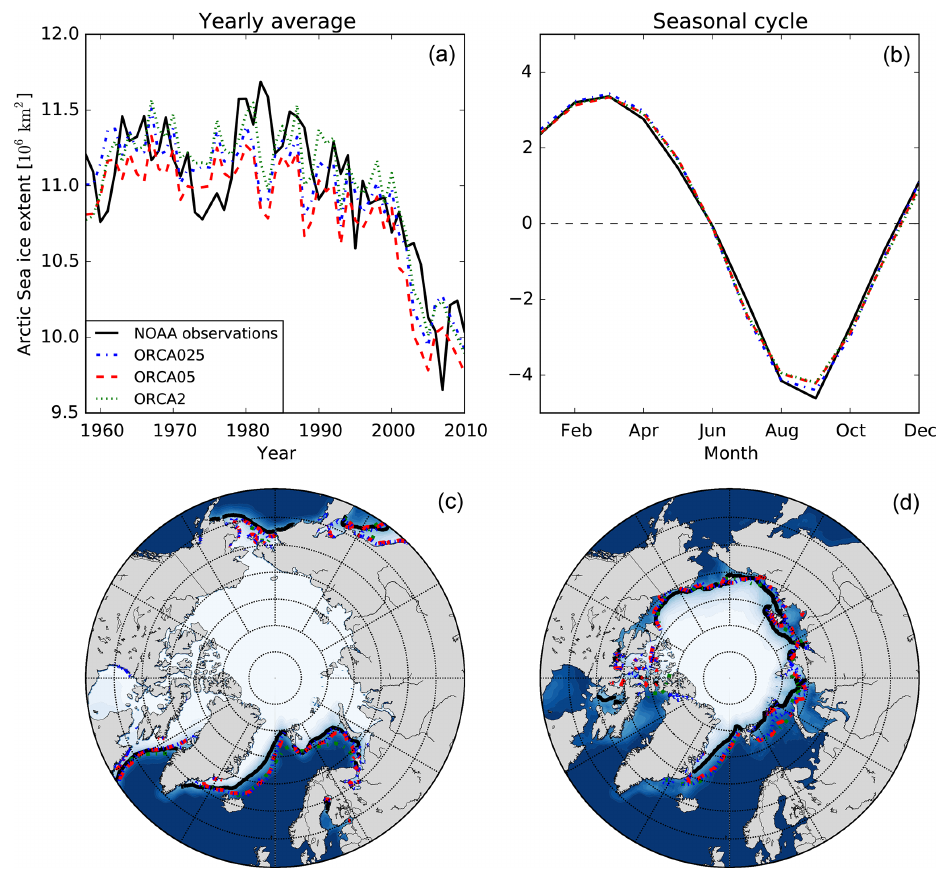
Figure 3. Sea-ice extent (a, b) and sea-ice concentration (c, d) over the Arctic from 1960 to 2012 comparing microwave-based observations from the National Oceanic and Atmospheric Administration (NOAA) (black) to simulated results from ORCA2 (green dots), ORCA05 (red dashes), and ORCA025 (blue dot–dash). Shown are the yearly averages (a) , the average (climatological) seasonal cycle over 1958–2010 (b) , and the average sea-ice extent in winter (December, January, February) (c) and summer (July, August, September) (d) . The lines on the maps show the 50% sea-ice cover for the three model resolutions and the observations, while the color indicates the observed sea-ice